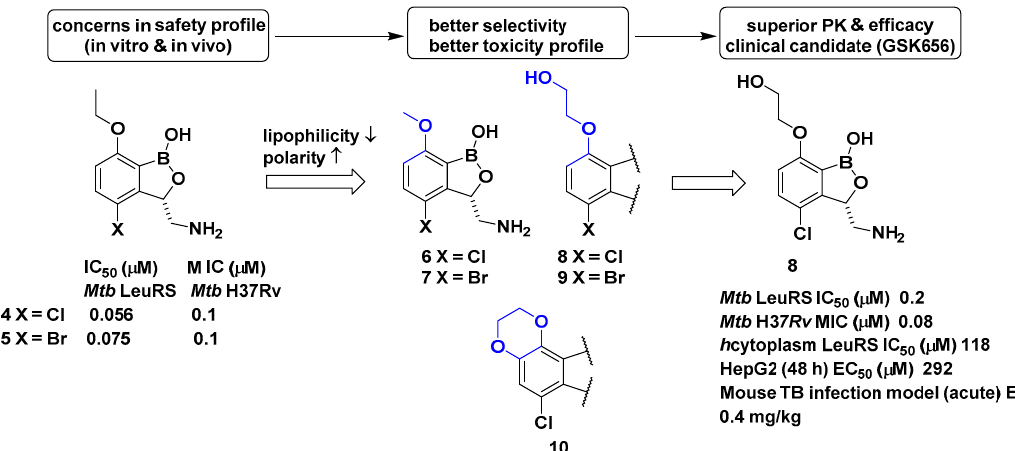
Figure 4. Development of GSK656 through hit-to-lead optimization.